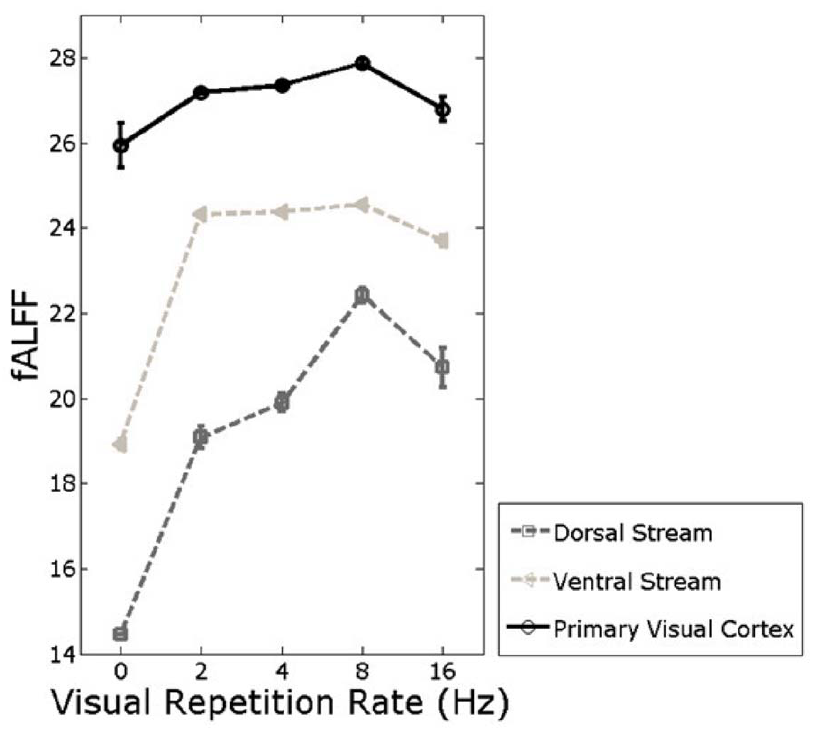
Figure 2. Impact of repetition rate on LFF power in three main areas of visual network.